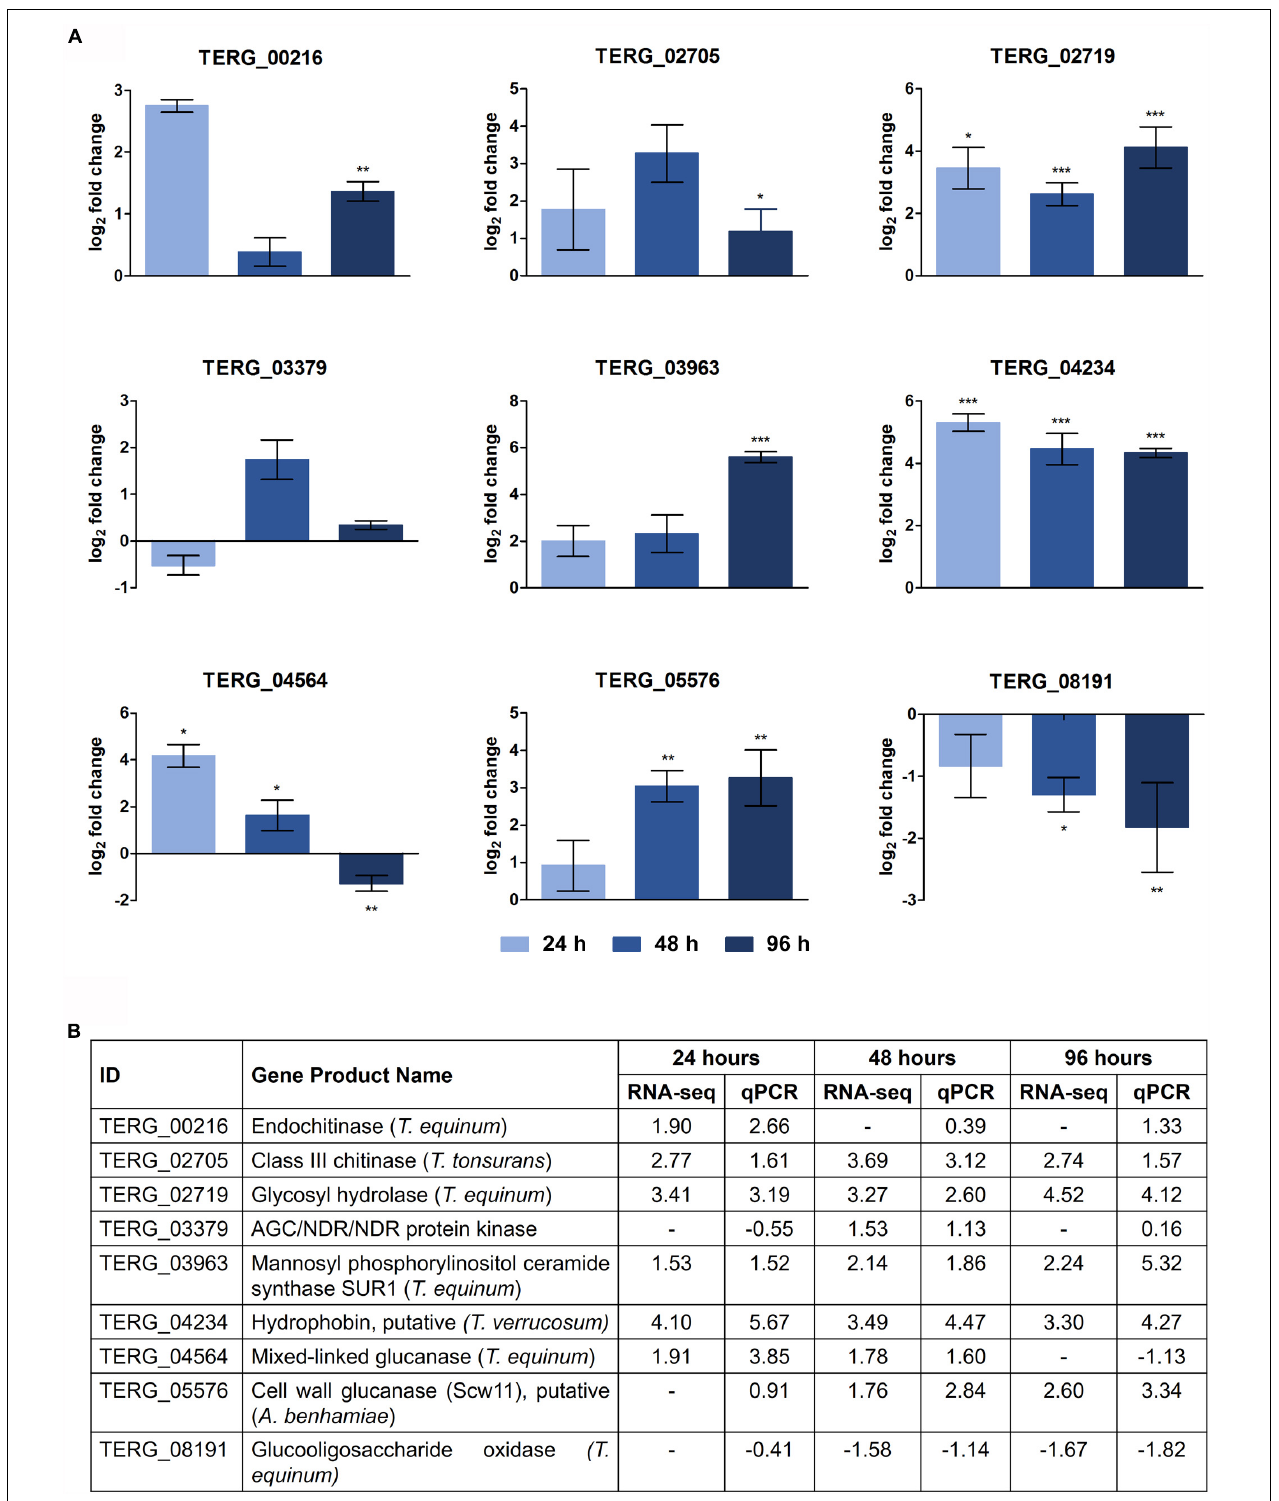
FIGURE 3 | Validation of DEGs under keratin cultivation by qRT-PCR. (A) Gene expression levels are represented as log 2 -fold changes relative to each control condition (24 h keratin × 24 h glucose; 48 h keratin × 48 h glucose; 96 h keratin × 96 h glucose). Asterisks indicate statistical significance determined by Student’s t -tests comparing treatment and control conditions at each time point ( ∗ P < 0.05; ∗∗ P < 0.01; ∗∗∗ P < 0.001). (B) Comparison of gene expression levels determined by RNA-seq with those evaluated by qRT-PCR (Pearson’s correlation, r > 0.82; P < 0.001).